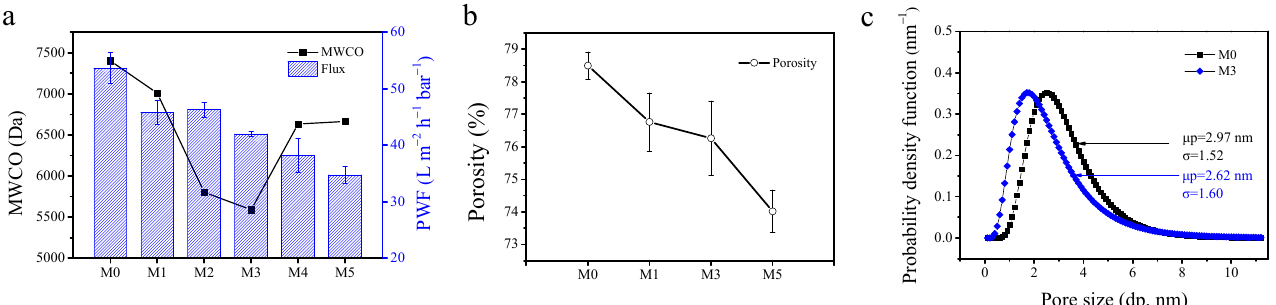
Figure 9. The pure water fluxes and molecular weight cut-off (MWCO) of membranes ( a ); the porosity of M0, M1, M3, and M5 ( b ); the pore size distribution of M0 and M3 ( c ).